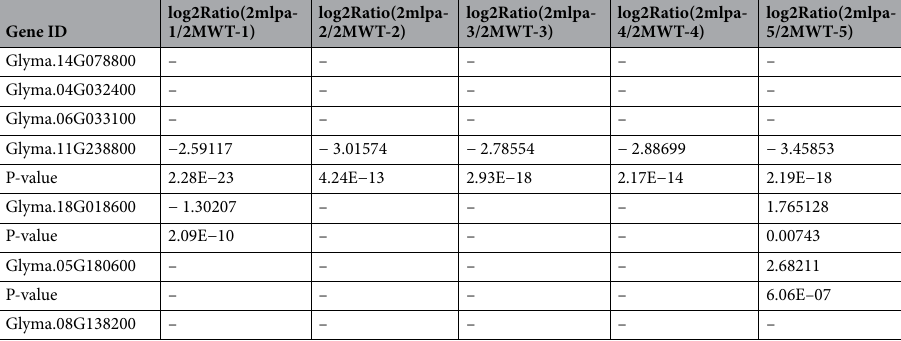
Table 3. Differential expression of MIPS1 and IPK1 orthologs in five seed developmental